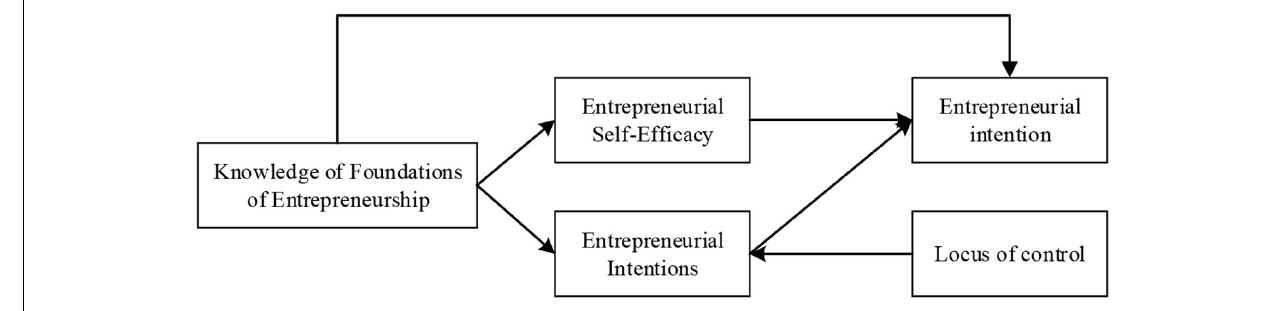
FIGURE 2 | Influencing factor model of college students’ entrepreneurial intentions.